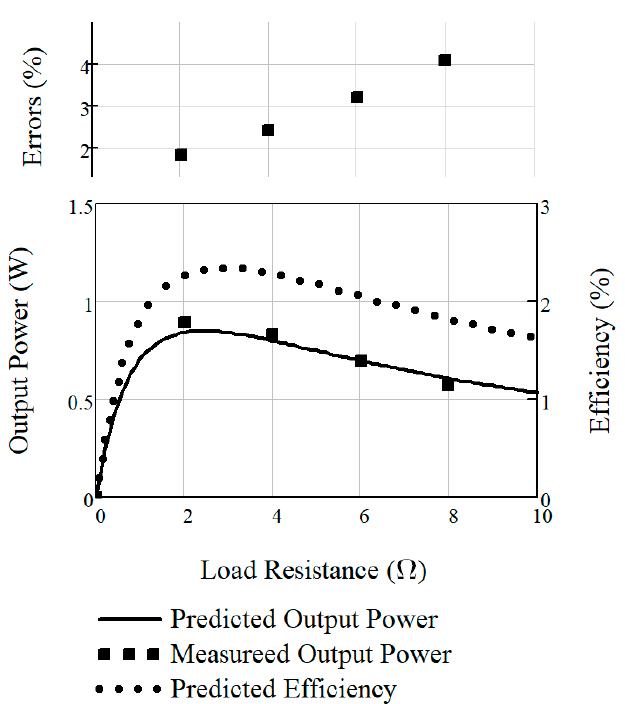
Figure 12. The relation between output power and its associated error and efficiency versus load resistance.